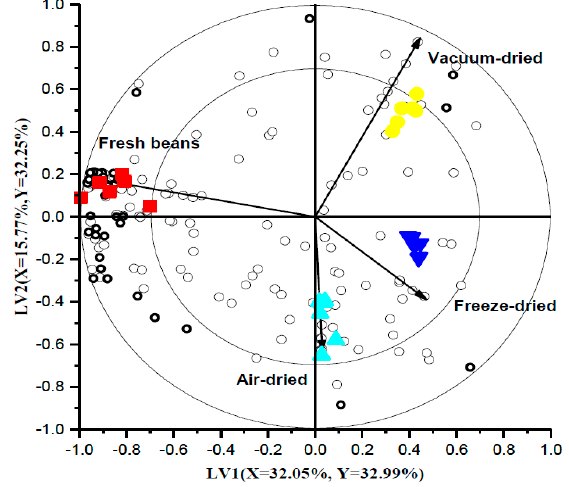
15 of 21 Figure 4. Color parameters L *( ◼ ) a * ( ◼ ) and b * ( ◼ ) and visual appearance of dried beans and fresh beans. Parameters not sharing the same letters are significantly different ( p < 0.05). 3.6. Texture Food texture and structure are inextricably linked and can depend on the plasticizing effect of water and the damage caused by processing. The average hardness (Table 2) of rehydrated AD and VD beans did not differ significantly from cooked fresh beans, while that of rehydrated FD beans was significantly ( p < 0.05) lower but was in the palatable range. Cryo-SEM micrographs of rehydrated FD beans confirm this textural observation, depicting higher cellular damage owing to the formation of ice crystals during freezing, leading to higher extracellular leached solids. Once the freeze-dried material is rehydrated, it quickly loses its elasticity of cellular texture and becomes more viscous. In contrast, AD and VD beans still retain their viscoelastic behavior after rehydration due to their strong, dense structure as a result of the considerable shrinkage [12]. This is also related to RRM (Table 2), which was the highest for rehydrated FD beans, implying its ability to absorb more water which, in turn, leads to a lower hardness. 3.7. Untargeted Volatile Fingerprinting The flavor profile of rehydrated dried beans was studied at their corresponding rehydration times and compared to that of cooked fresh beans. In this study, the volatile profile of non-cooked beans was not considered as it is the cooked/rehydrated beans that are of critical importance from a sensorial point of view. A significant reduction ( p < 0.05) in the total peak area (results not shown) was observed between the rehydrated dried beans and the cooked beans, with AD being significantly higher than FD and VD (not different). The loss of volatiles occurs during cooking and drying, both being key steps in the process. A PLS-DA model with three LVs was applied to understand and compare the volatile fractions between the cooked and rehydrated dried beans, in which LV1 and LV2 were chosen to build a bi-plot (Figure 5). The grouping and/or separation between the treatments was visualized with closer classes, being considered similar and vice versa. In this regard, rehydrated AD and FD beans are close, meaning they have similar volatile